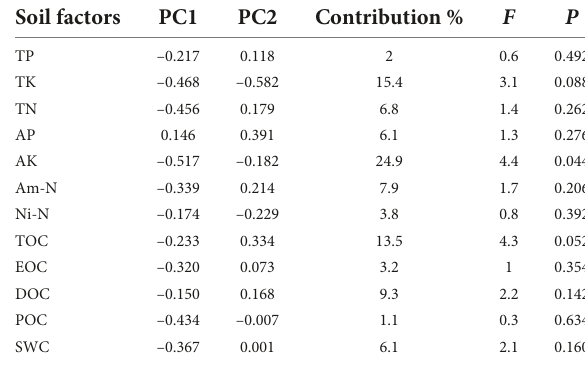
TABLE 3 The vector value, contribution rate, F value and P -value of soil factors on the RDA ranking